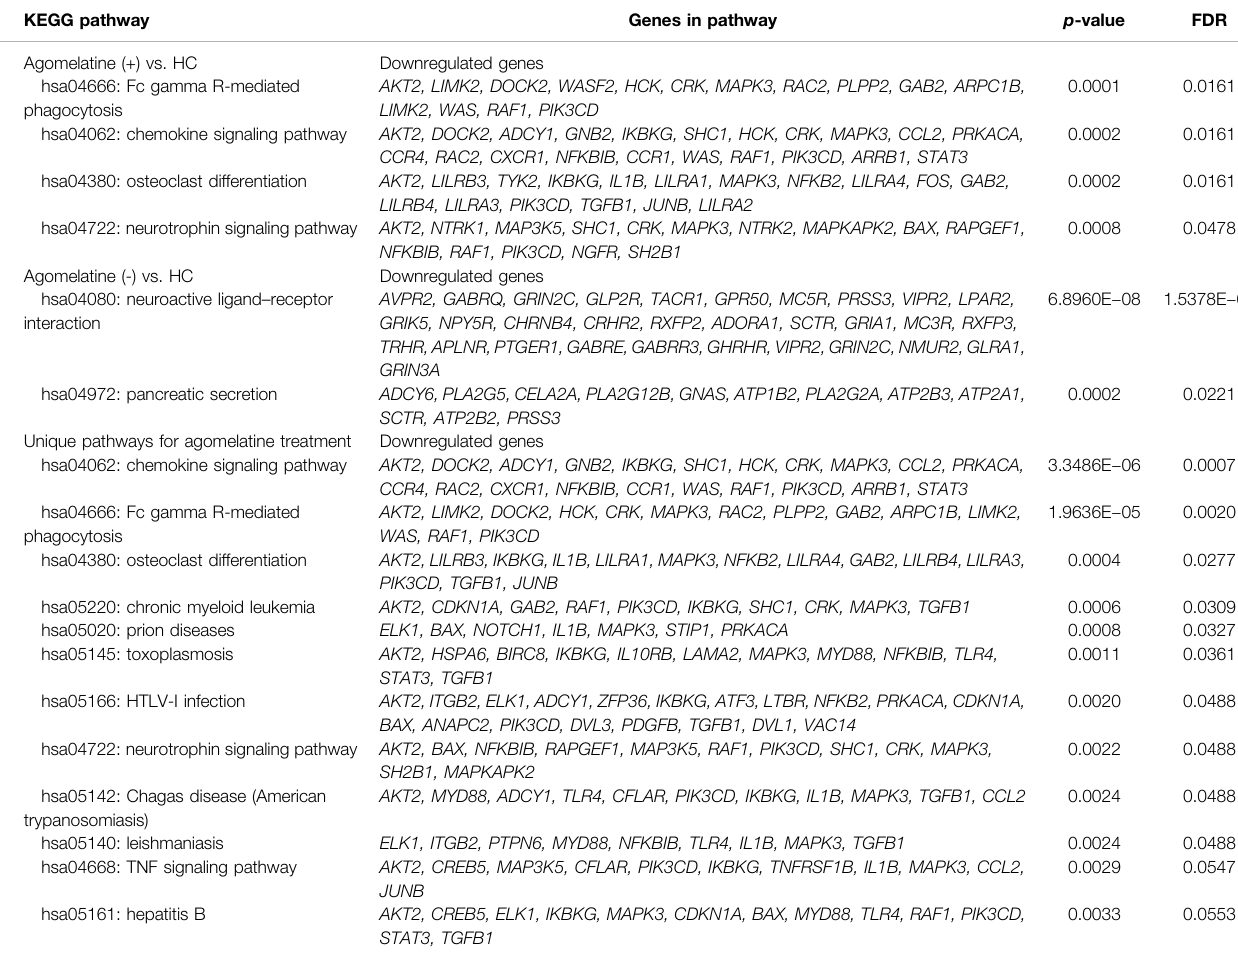
TABLE 6 | KEGG pathways pass after FDR correction. KEGG pathway Genes in pathway p -value FDR Agomelatine (+) vs.